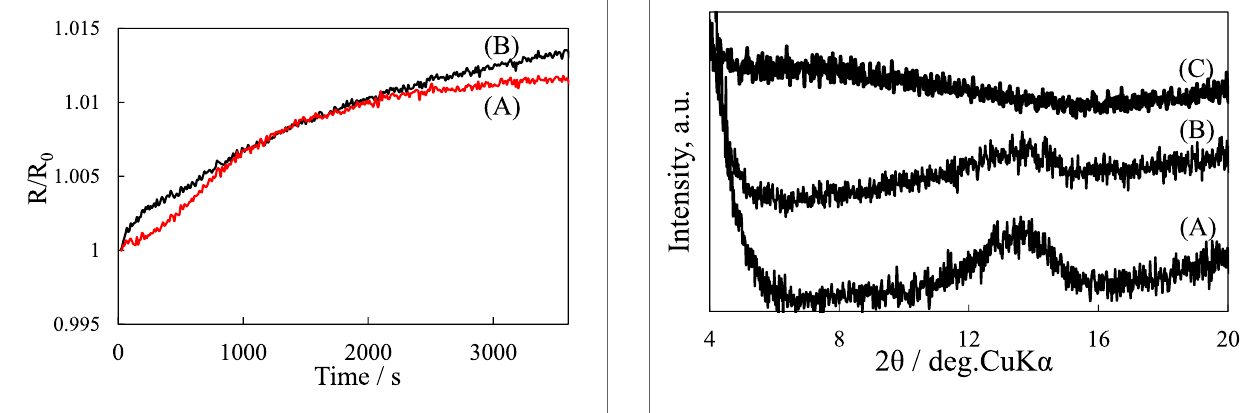
FigUre 7 | X-ray diffraction patterns of pillared carbons obtained from